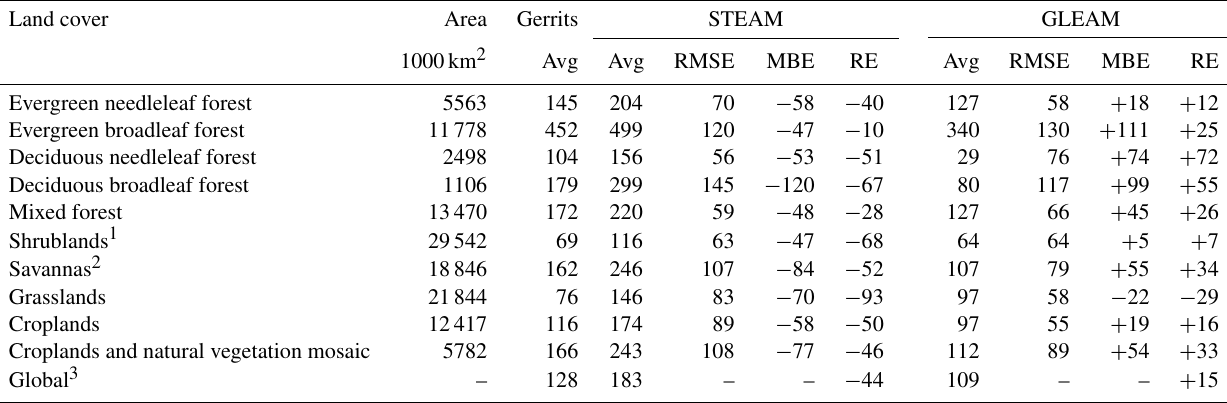
Table 4. Comparison of interception estimated by Gerrits’ model to STEAM and GLEAM through average, RMSE, MBE, and RE per land cover type. Negative MBE and RE show Gerrits’ model underestimates evaporation and vice versa. Average, RMSE, and MBE are in mmyr − 1 and RE is in %.